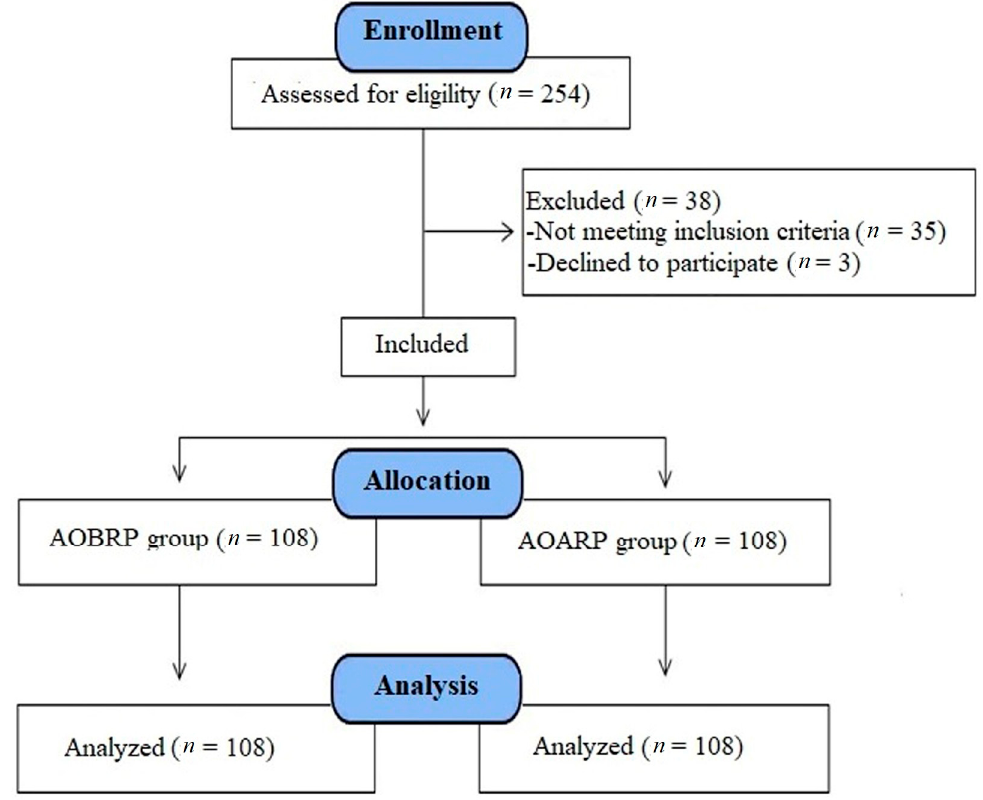
Figure 1. Flow consort chart of the study.